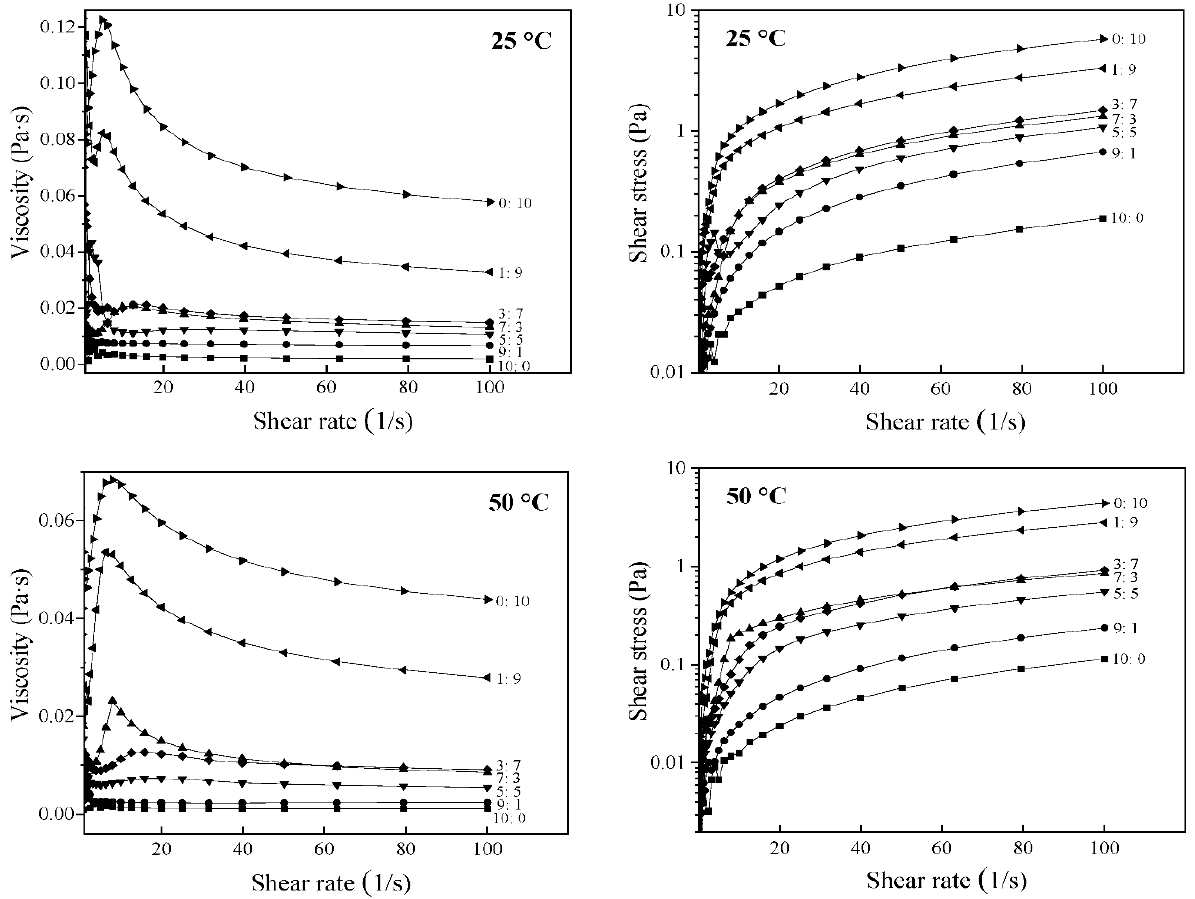
Figure 3. Shear rheological curve of WP-OS-capsaicin emulsion. 10:0, 9:1, 7:3, 5:5, 3:7, 1:9, and 0:10 represent WP (whey protein):OS (OSA-modified starch).